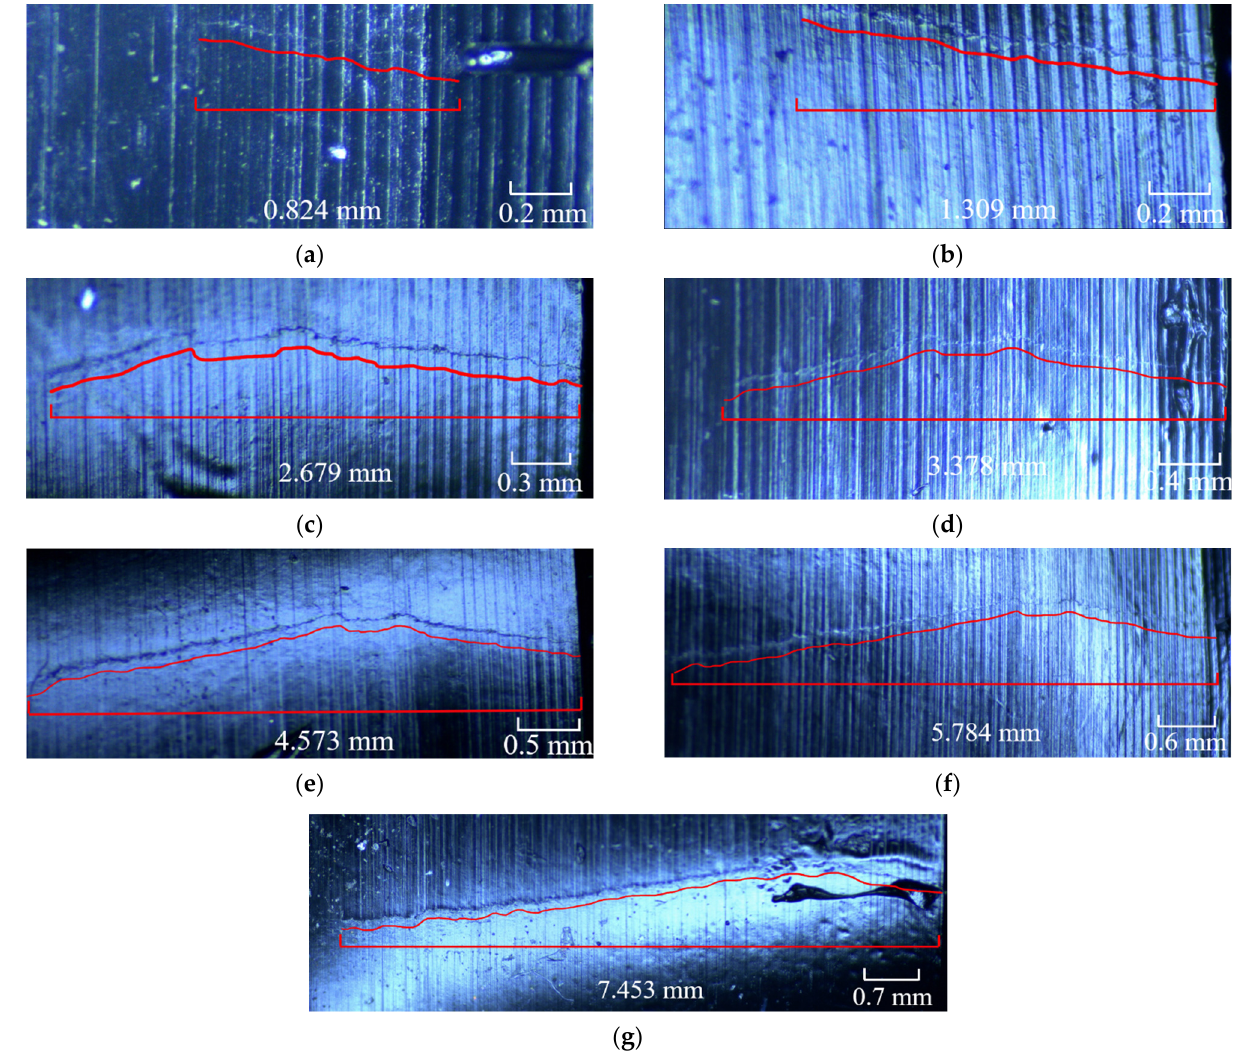
Figure 15. Detecting crack length of D01 disc using the surface replica method. ( a ) 1500 cycles, ( b ) 2000 cycles, ( c ) 2500 cycles, ( d ) 2700 cycles, ( e ) 2900 cycles, ( f ) 3100 cycles, ( g ) 3300 cycles. The external surface crack length versus crack propagation life of all five discs recorded using the surface replica method is shown in Figure 16.